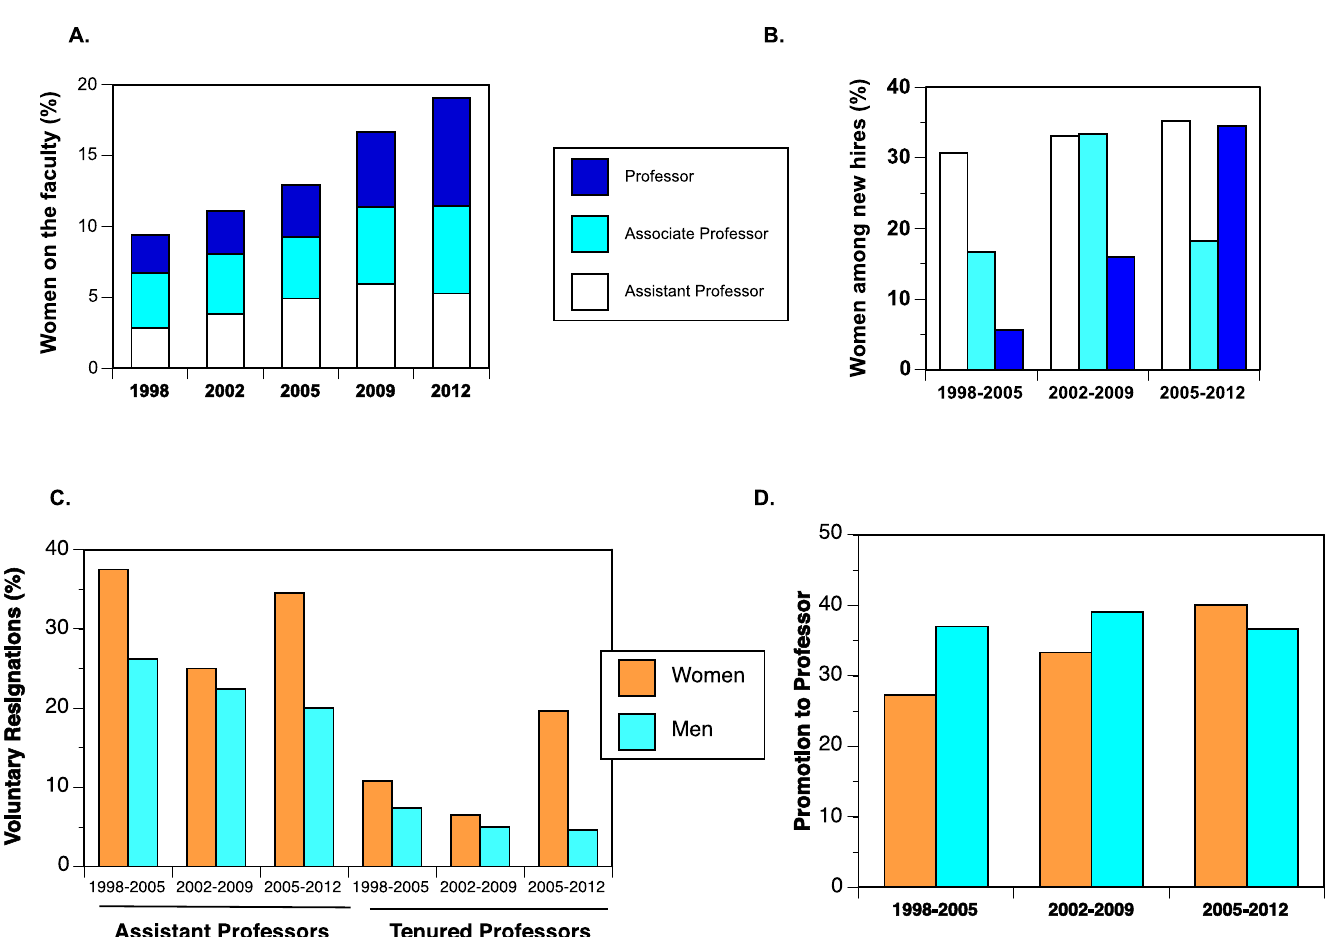
Fig 2. Faculty flux across the three cohorts. A. Gender representation of the faculty across time. B. Recruitment of women to the faculty C. Voluntary resignations among faculty. D. Promotion rates for Associate